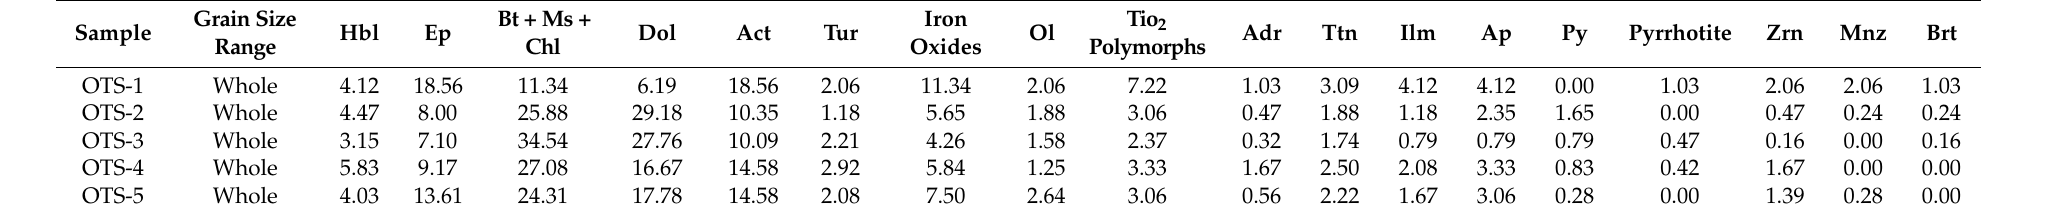
Table 2. The major heavy mineral content (>1%) of H4-S2.